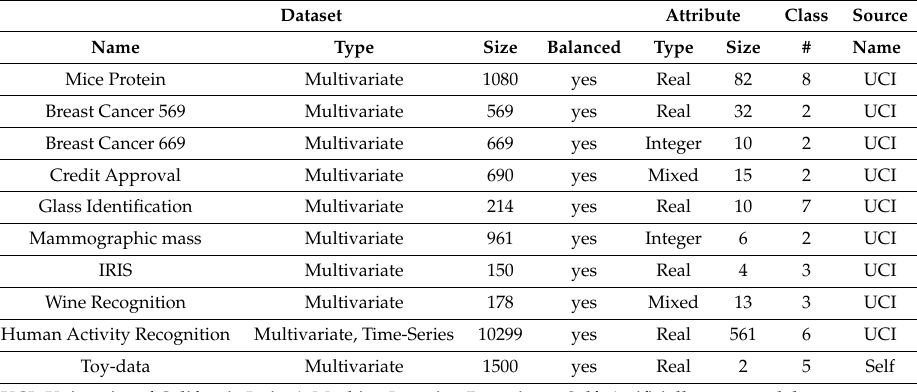
Table A4. Dataset description.